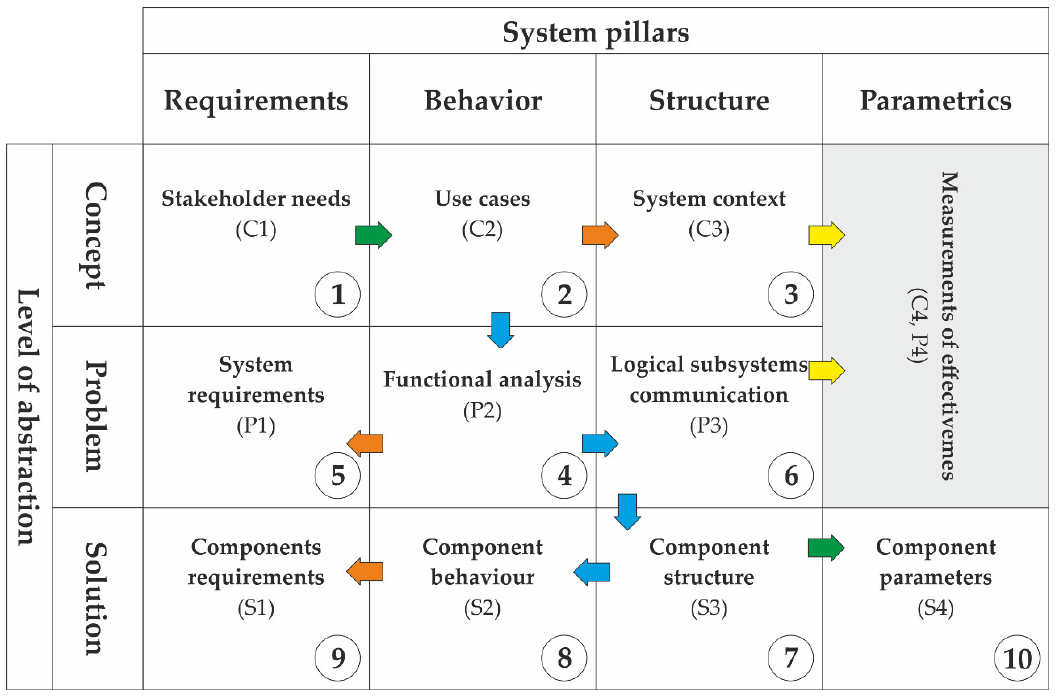
Figure 4. MagicGrid workflow [33].